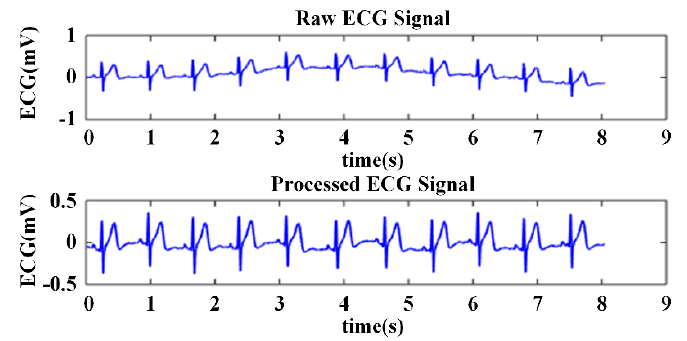
Figure 9. Comparison of the raw and preprocessed ECG signal.